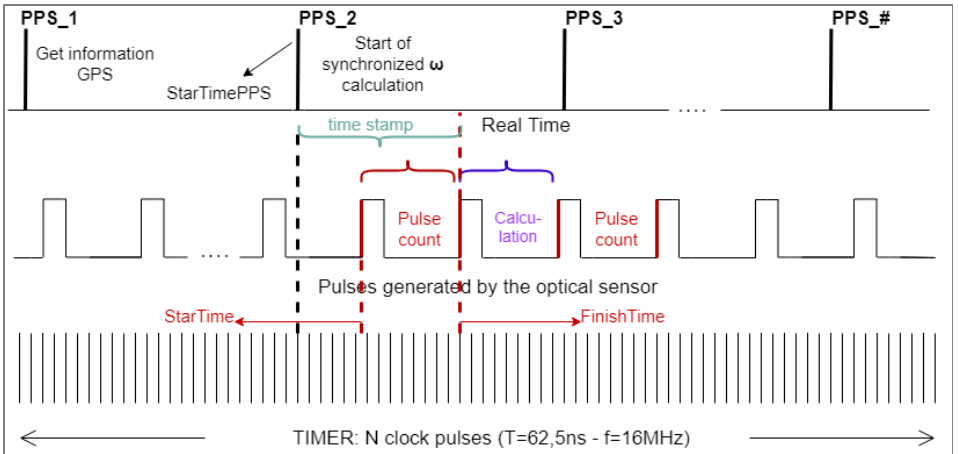
Figure 5. Synchronization diagram with a timestamp.